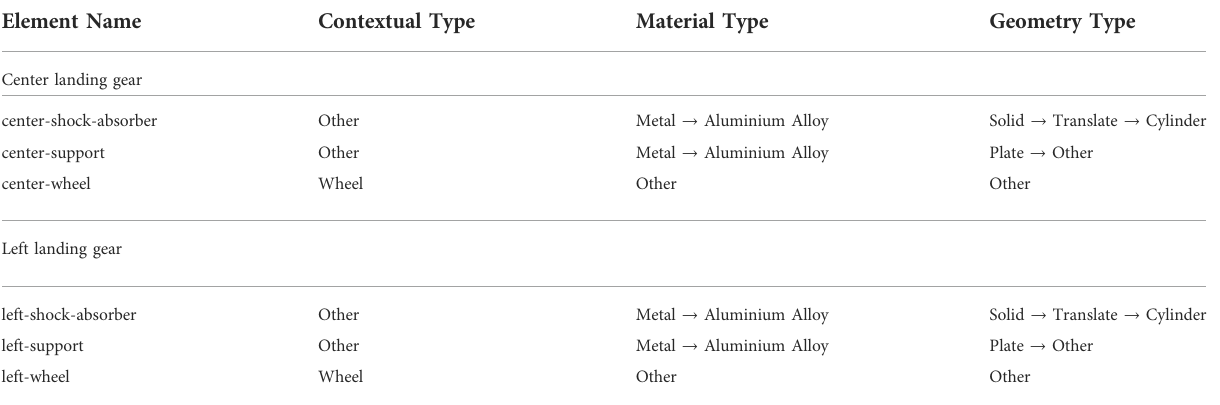
TABLE A3 Regular elements.